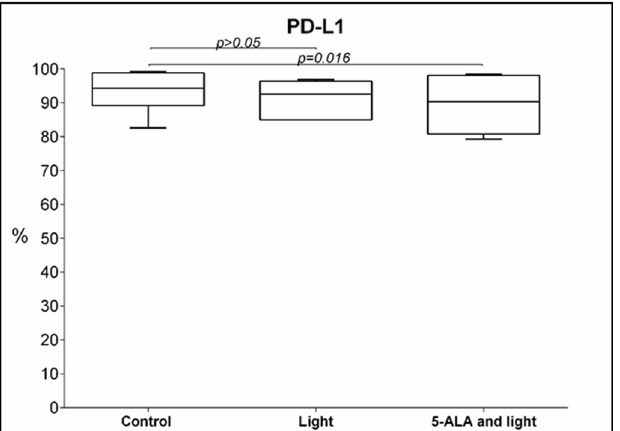
Figure 6. Boxplot showing the change in the percentage of PD-L1-positive GB-MSCs across paired samples of control cell cultures, cell cultures treated with light only, and cell cultures exposed to 5-ALA and light. The PD-L1 expression was evaluated using multi-color flow cytometry, and every dot on the box plot represents the percentage values of all the PD-L1 positive GBM-MSCs in that particular cell culture.